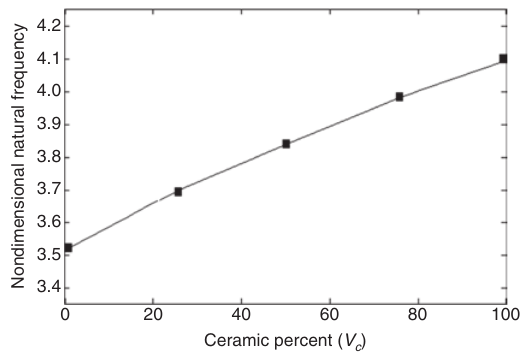
Figure 5 Variation of nondimensional natural frequency of the microgripper due to the ceramic volume.